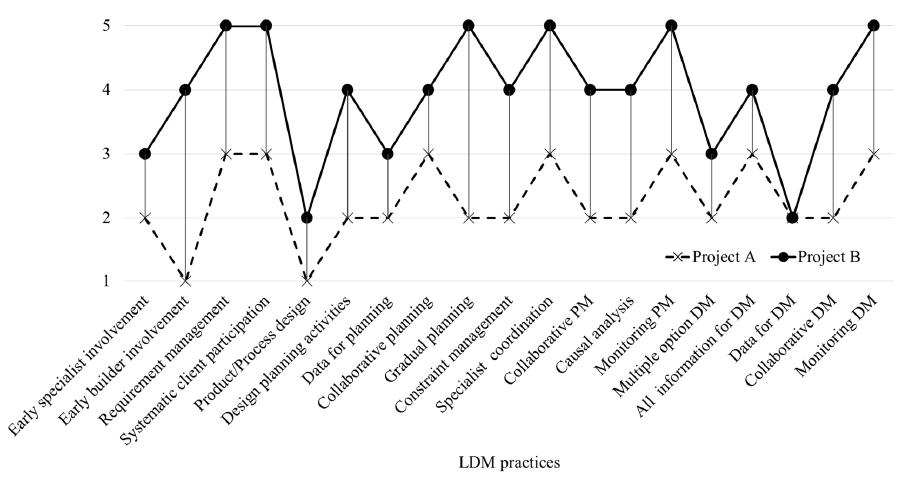
Figure 2. LDM practices assessment: Project A and project B.